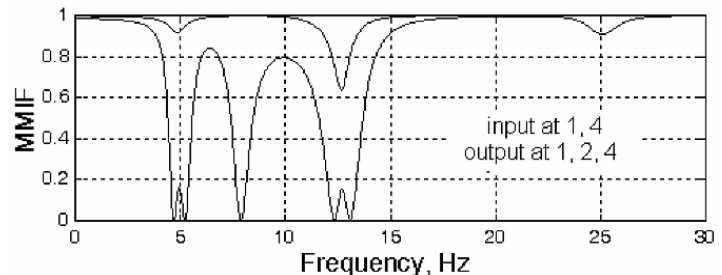
Fig. 4. MMIF for the 5-dof system, case 1.